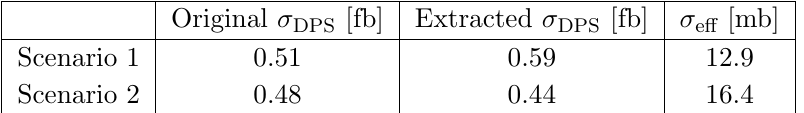
Table 4 . Extracted DPS cross sections from template (cid:12)ts. Scenario 1 (Scenario 2) generates data based on correlated (uncorrelated) DPS and extracts the signal assuming uncorrelated (correlated) DPS. We also give the value for the e(cid:11)ective cross section in the two scenarios (based on a (cid:27) e(cid:11) = 15 mb used in the main analysis).